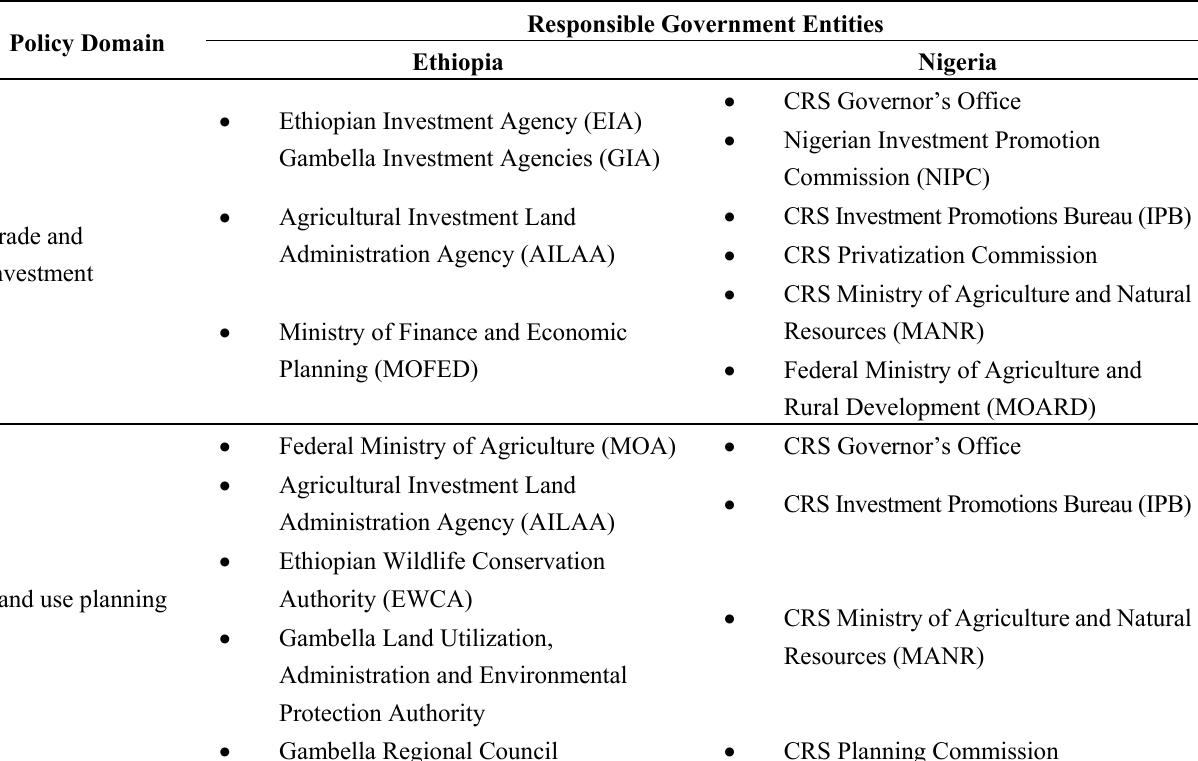
Table 2. Government entities involved in the different policy